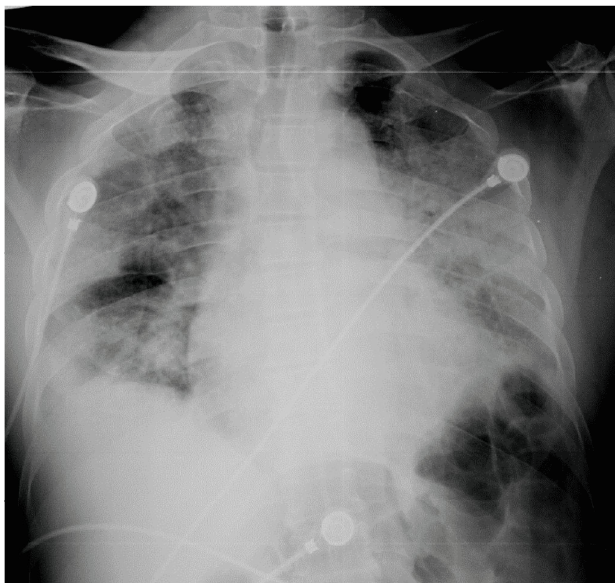
Figure 2: Chest radiograph of case 1 on day 3 of ICU showing progression of air space opaci fi cation in both lungs. Table 1: Laboratory investigations of the patients presented with silent